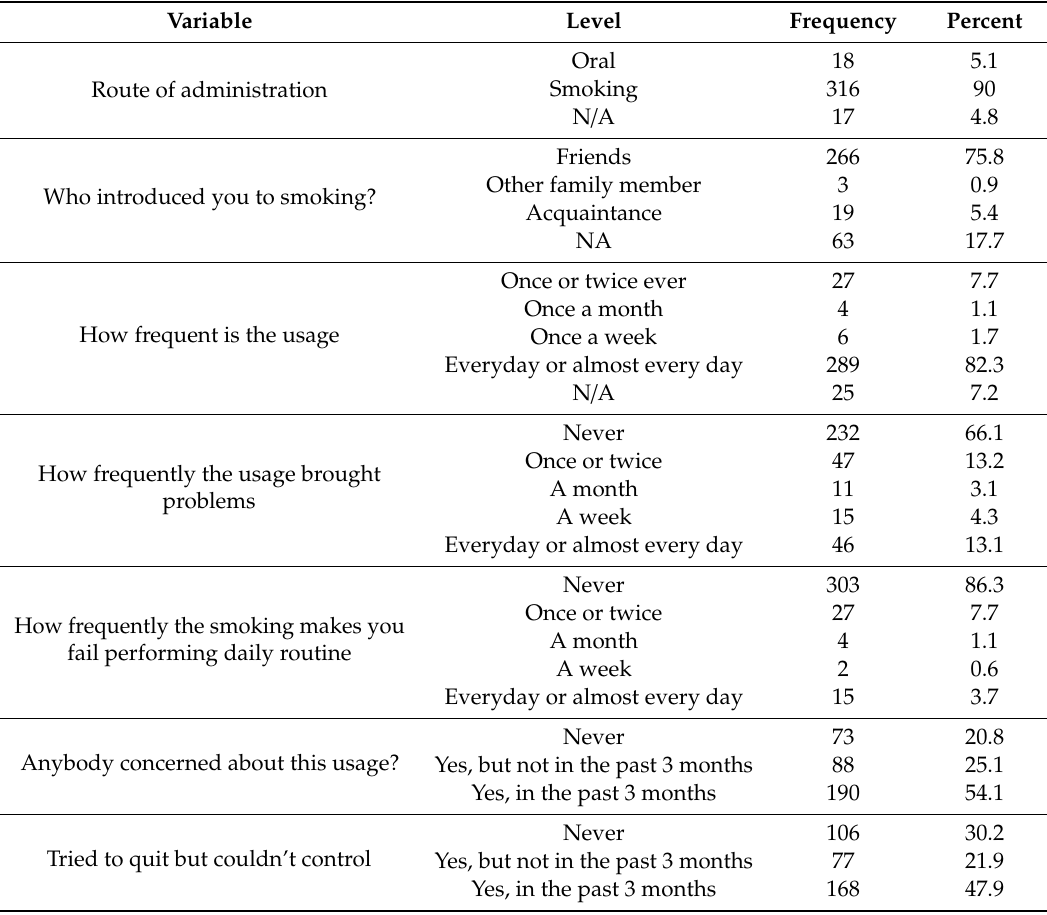
Table 2. Patterns of smoking among